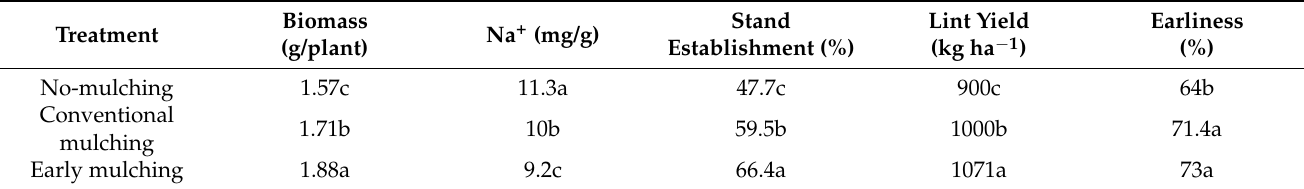
Table 3. Effects of strategies approach to no, early and conventional mulching interactions effect of cultivation practices on plant Na + content, biomass (g/plant), lint yield, stand establishment, and earliness (%). Treatment